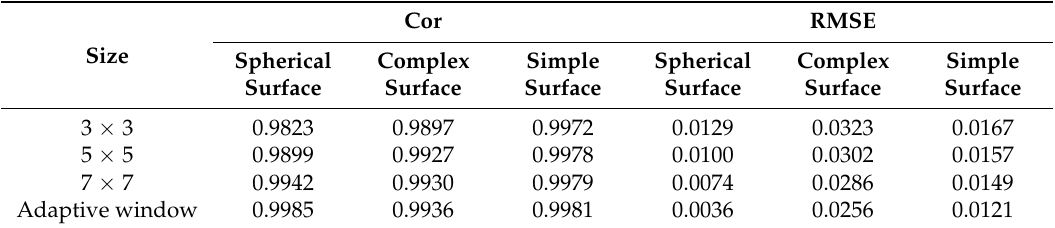
Table 2. Evaluation result of the recovery effect of the three models reconstructed using different evaluation windows of F SML.